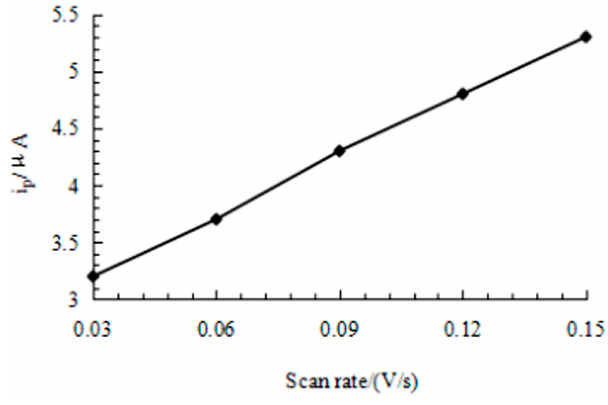
Figure 8. The peak current of CGA at different scan rate.